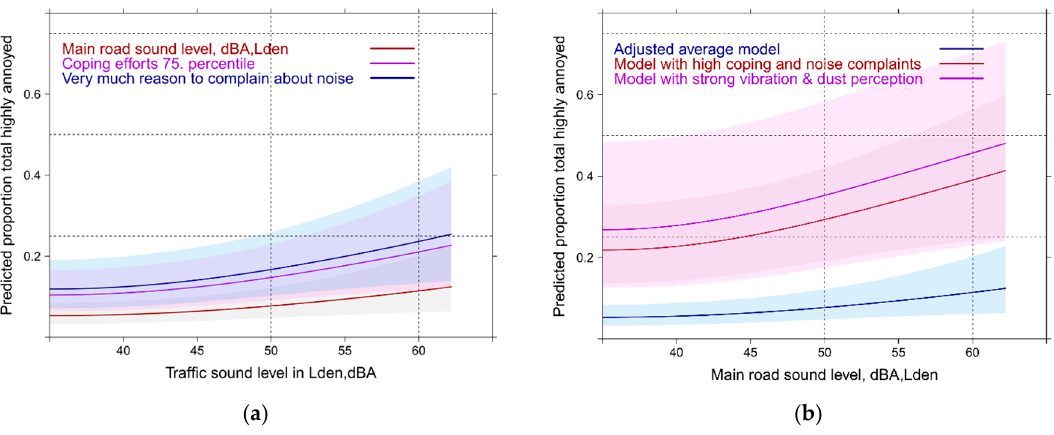
Figure 18. Predicted proportion of total annoyance associated with sound from all sources. ( a ) Proportion highly annoyed; ( b ) Proportion highly annoyed associated with main road. Models are adjusted for age, gender, education, health status, complaints about community soundscape and air pollution, perceived vibration, perceived dust/soot from road, coping, anger at traffic load and the respective other sound sources.